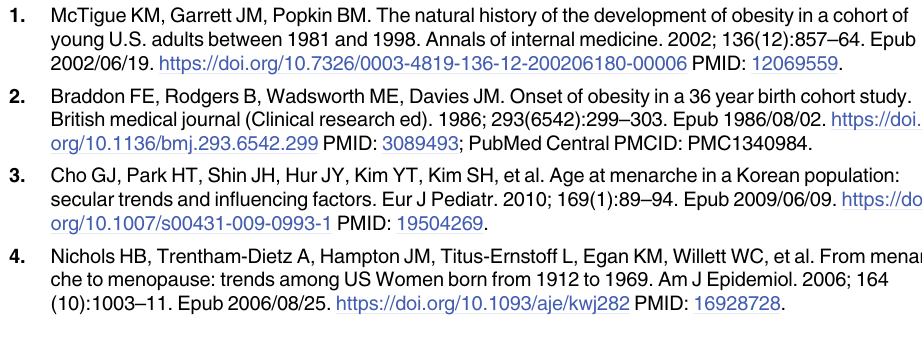
S5 Table. The association of educational attainment and AAM/young-adulthood BMI. S6 Table. Association of potential confounders with instrumental variable (IV) in the Korean Genome and Epidemiology Study (KoGES) and Healthy Twin Study (HTS), (n = 10,000). S7 Table. Result of two-sample summary MR method for exploring the association between age at menarche (AAM) and young adulthood body mass index without rs1428120. S8 Table. Result of MR-base for exploring the association between age at menarche (AAM) and